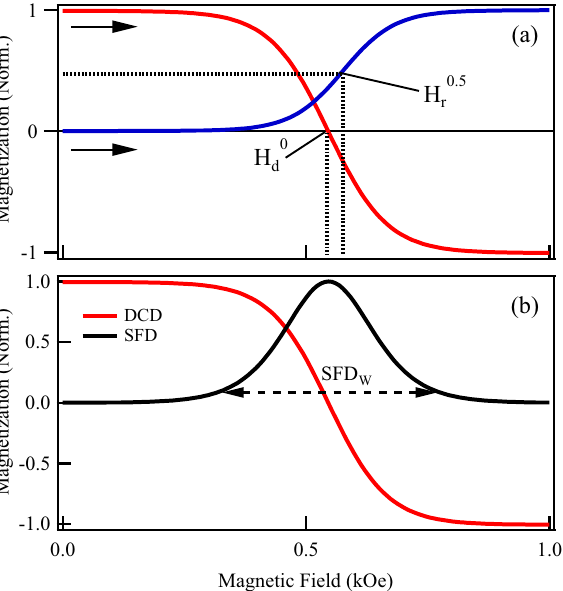
Figure 7. ( a ) Typical IRM and DCD remanence curves. The field value at which the normalized IRM curve is equal to 0.5, H 0.5 r , and the field value at which the DCD curve is zero H 0 d are indicated. The arrows indicate the field sweep sense. ( b ) The DCD remanence curve and its derivative (SFD), where the maximum width, SFD W is